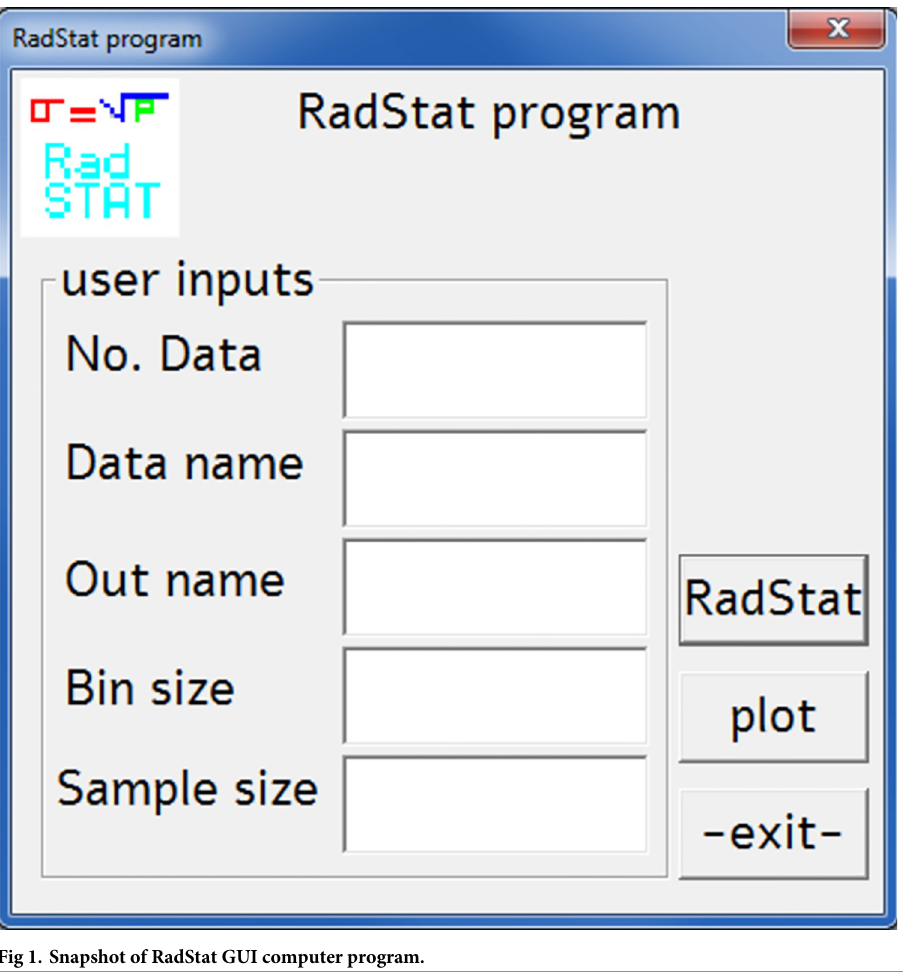
Fig 1. Snapshot of RadStat GUI computer